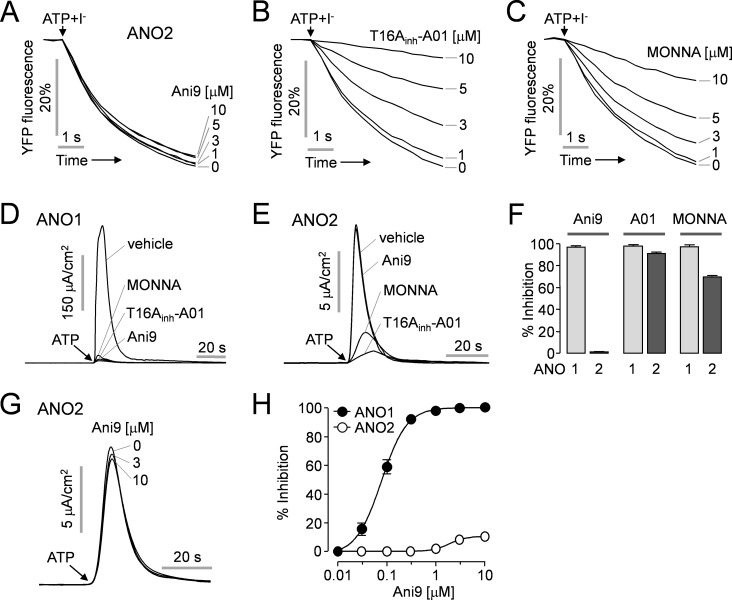
Effect of Ani9 on ANO2 activity.A-C) YFP Fluorescence measurement showing inhibition of mouse ANO2 activity by Ani9, T16Ainh-A01 and MONNA in FRT cells expressing ANO2 and a halide sensor YFP. The indicated concentrations of the inhibitors were applied 20 min prior to ANO2 activation by 100 μM ATP. D) Apical membrane current was measured in FRT-ANO1cells. 1 μM Ani9, 10 μM T16Ainh-A01 and 10 μM MONNA were applied 20 min prior to ANO1 activation. E) Apical membrane current was measured in FRT-ANO2 cells. 1 μM Ani9, 10 μM T16Ainh-A01 and 10 μM MONNA were applied 20 min prior to ANO2 activation. F) Summary of peak currents of ANO1 and ANO2 (mean ± S.E., n = 4). G) Representative current traces showing Ani9-induced ANO2 inhibition at the indicated concentration. H) Summary of dose responses of ANO1 and ANO2 (mean ± S.E., n = 4–6).